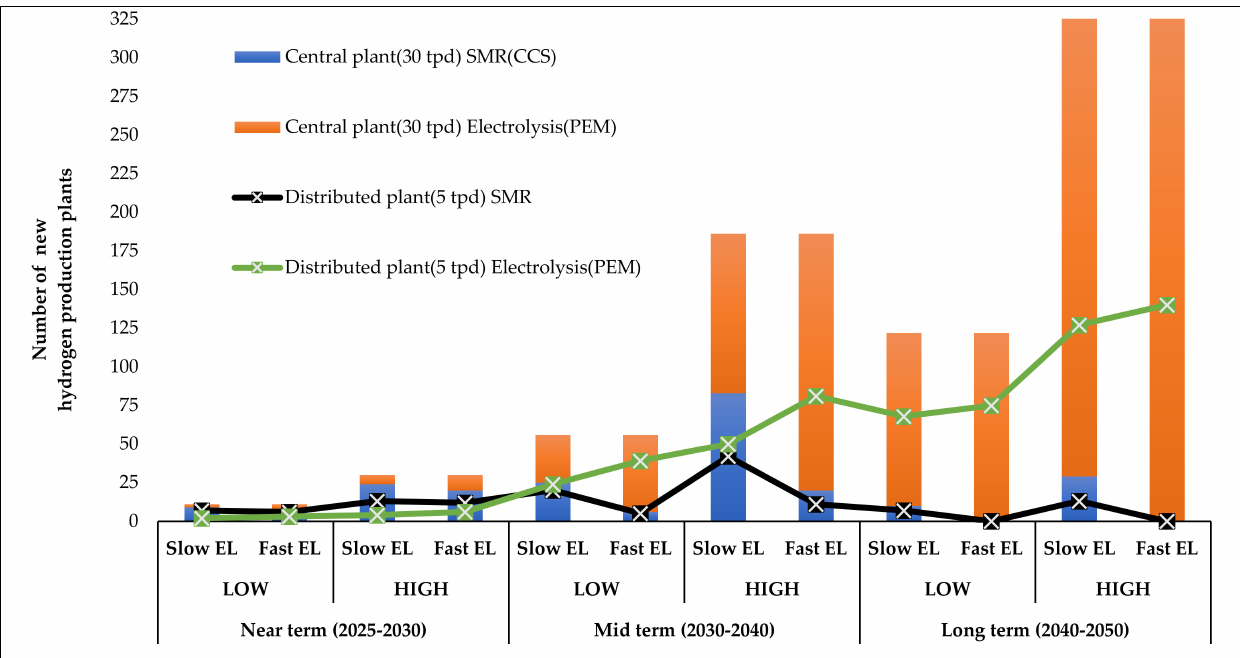
Figure 3. Projections of hydrogen production facilities in California for different demand and technology adoption